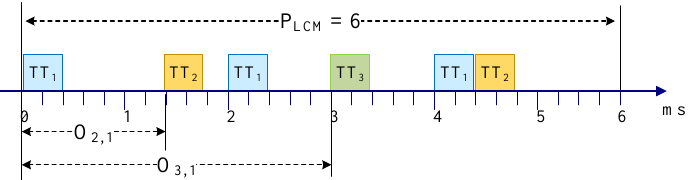
Figure 4. Period of aggregated TT